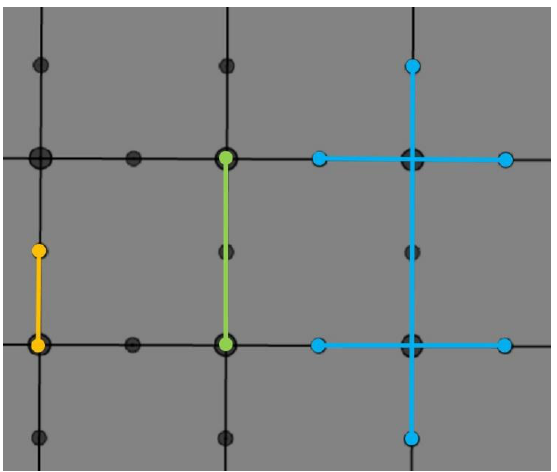
Figure 5. From the left: a virtual, a physical, and a logical segment. Larger and smaller nodes represent physical and virtual nodes, respectively.